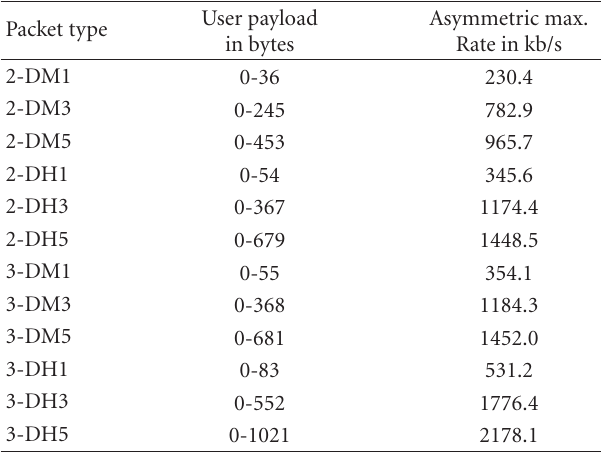
Table 1: Basic and EDR packet types in Bluetooth ACL model, with extra suggested EDR DM type